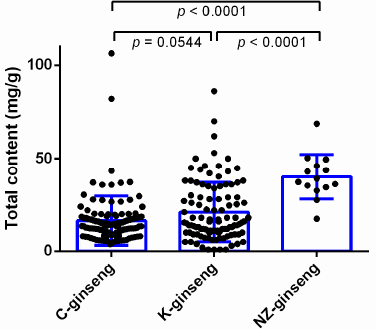
Figure 3. The average content of total ginsenosides in the ginseng roots grown in three different countries. Data were analyzed by one-way ANOVA using Graph pad prism 6 software and expressed as mean ± SE. Differences were considered significant if p < 0.05. Each dot represents one batch of ginseng sample test datum. C, K, and NZ-ginseng refers to China (n = 113), Korea (n = 106), and New Zealand (n = 14) grown ginseng, respectively.